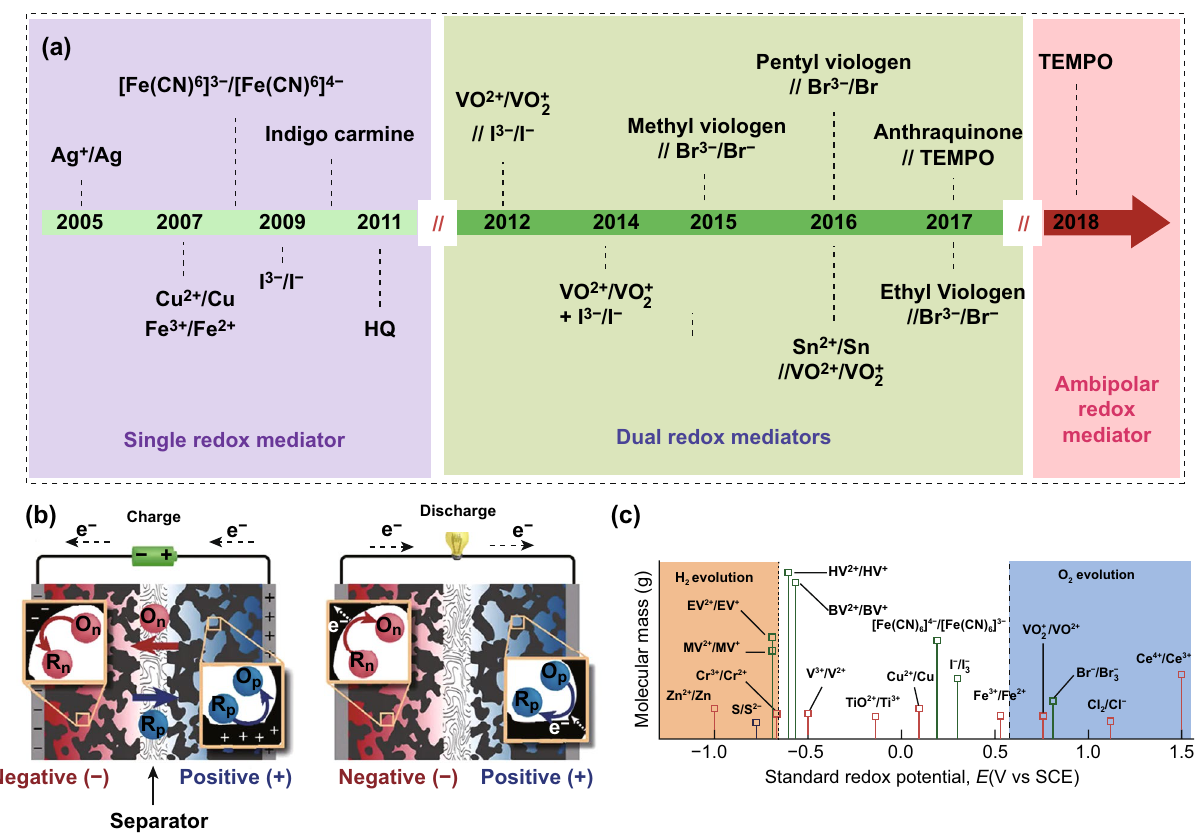
Fig. 6 a Timeline of the development of redox couples in the field of SCs. HQ and TEMPO refer to hydroquinone and 2,2,6,6‑tetramethylpi‑ peridinyloxyl. Adapted with permission from Ref. [64]. b Schematic showing capacitive and faradic charge‑storage processes of redox couples in electrolyte. c Reduction potentials of the couples considered relative to the thermodynamic stability window of water at neutral pH (white region). The lines colored in red, green, and blue are for couple stable in acidic, neutral, and basic conditions, respectively. BV: benzyl viologen, EV: benzyl viologen, HV: heptyl viologen, MV: methyl viologen, SCE: standard calomel electrode. Adapted from with permission Ref. [76]. (Color figure